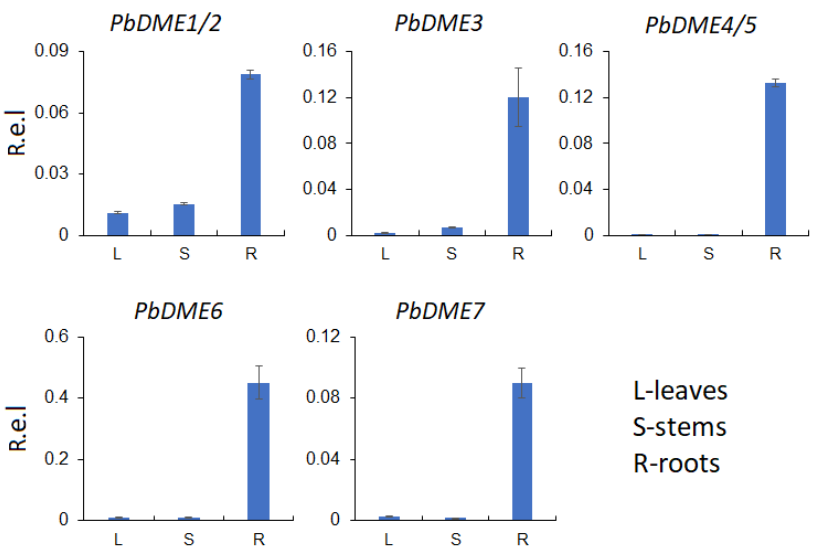
Figure 5. Relative levels of expression of PbDME genes in different pear tissues. Level of DME gene expression in leaves, stems, and roots of pear as determined by reverse transcription-quantitative PCR (RT-qPCR) using the 2 −∆ ∆ CT method. R.e.l indicates relative expression level.